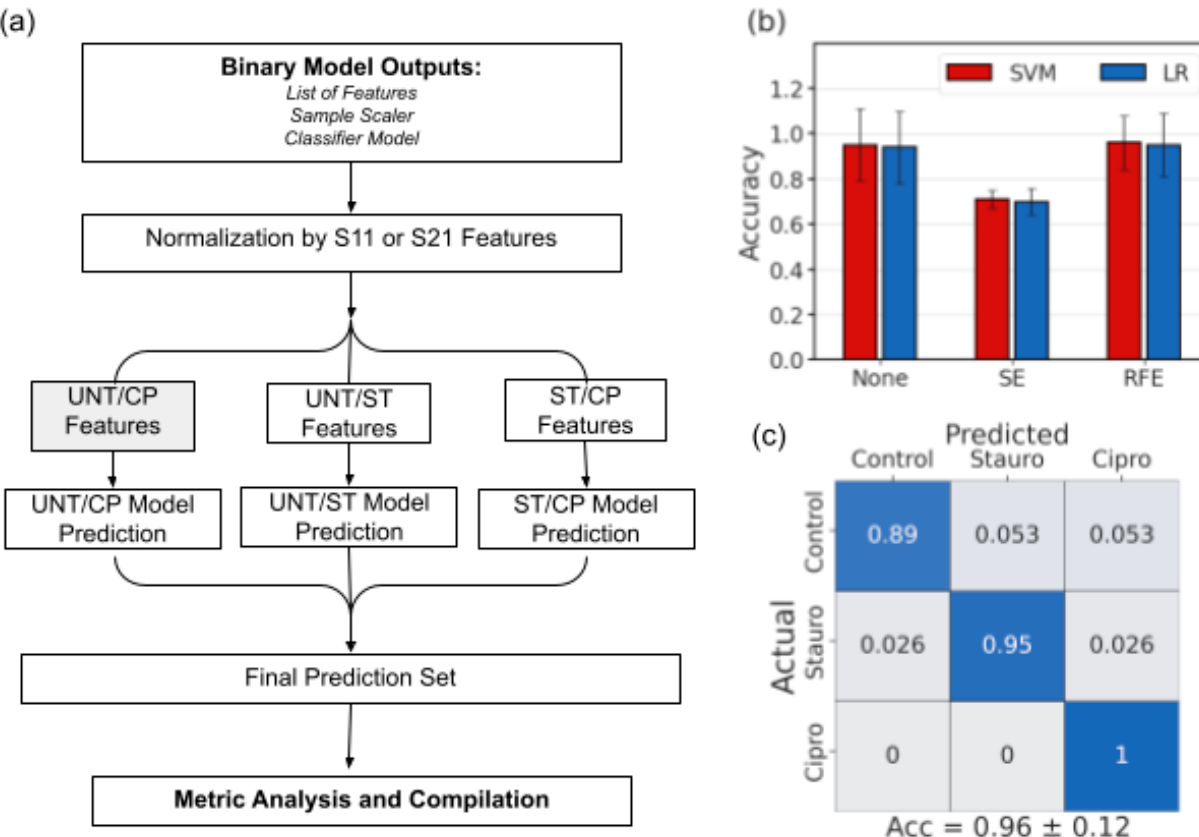
Figure 5. Multiclass classification approach using major voting and previous binary classifier results. ( a ) Schematic describing the multiclass voting structure. ( b ) Final classification accuracy of the mul- ticlass predictions for 10 randomly selected cells. ( c ) Confusion matrix describing prediction percent- ages for each cell type.